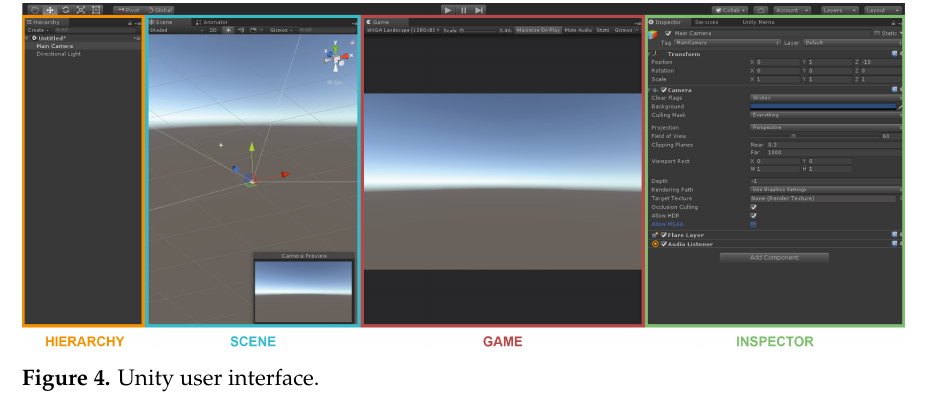
Figure 4. Unity user interface.